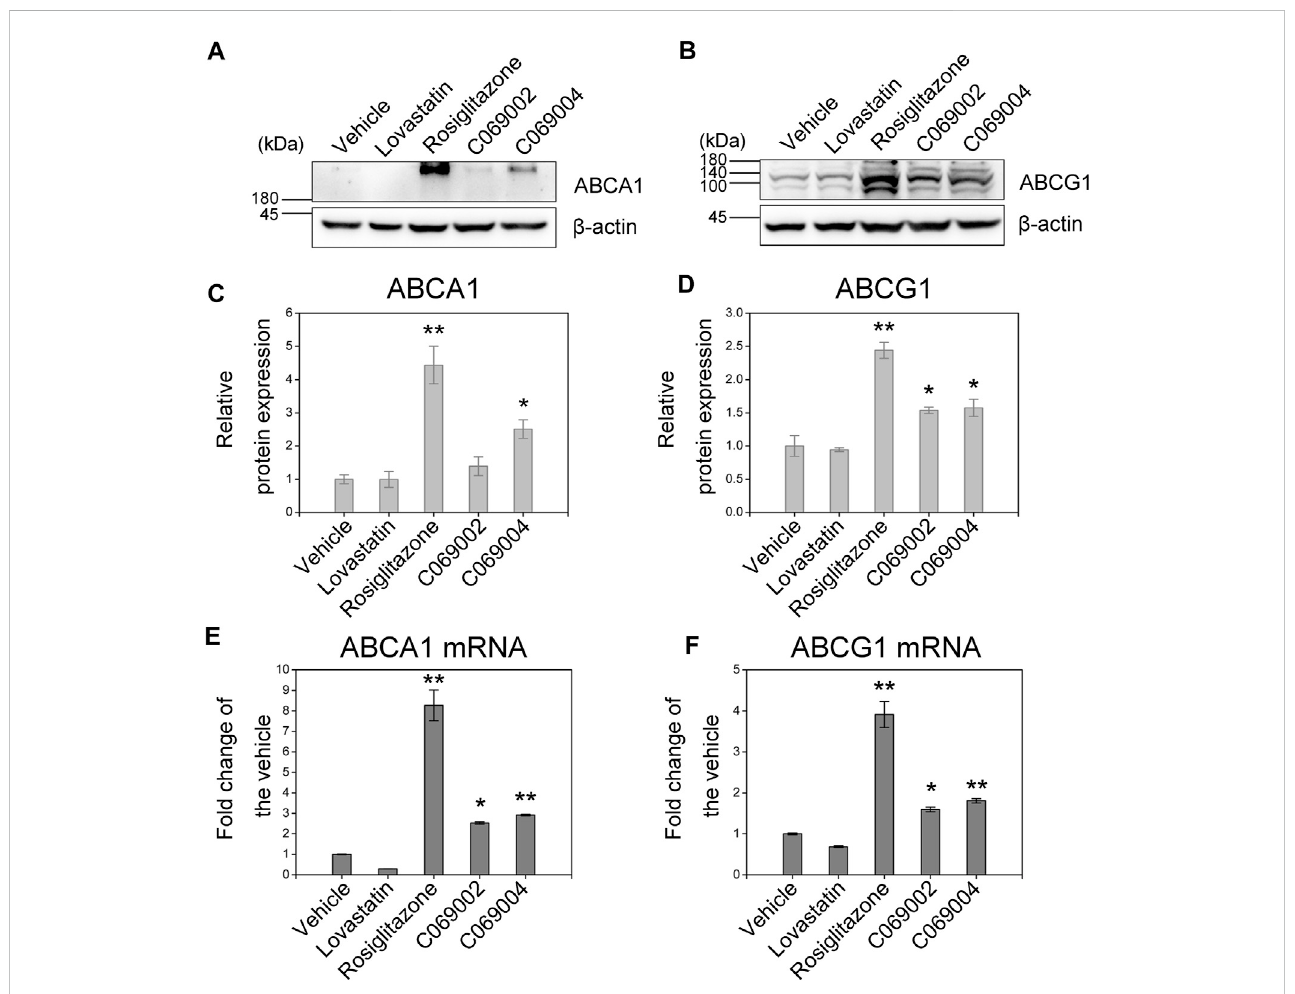
FIGURE 5 Diterpenoids increase ABCA1 and ABCG1 expression. RAW264.7 macrophages were treated with 15 μ mol/L indicated drugs and chemical compounds for24 h.Celllysateswerecollected,andtheproteinlevelsofPPAR γ (A) andLXR α (B) weredeterminedbywesternblotting.Correspondingquantitativeresults areshown asthemean±SEM fromthreeindependentexperiments (C,D) .CellularRNAwascollectedfor quantitative real-time PCR(qRT ‒ PCR)analysis.Data are shown as the mean ± SEM from three independent experiments (E,F) . Signi fi cance is presented as * p < .05 and ** p < .01 versus the vehicle (DMSO)